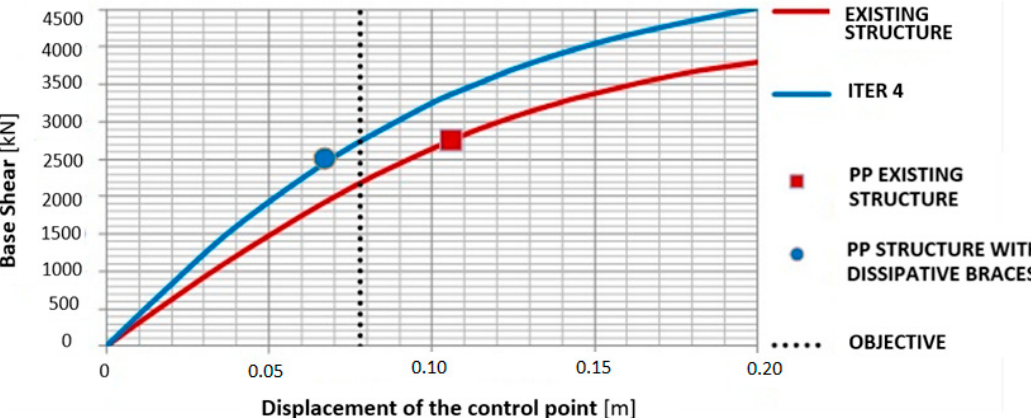
Figure 14. Capacity curves in X direction after retrofitting, with the relative performance points (PP) and objective displacement.